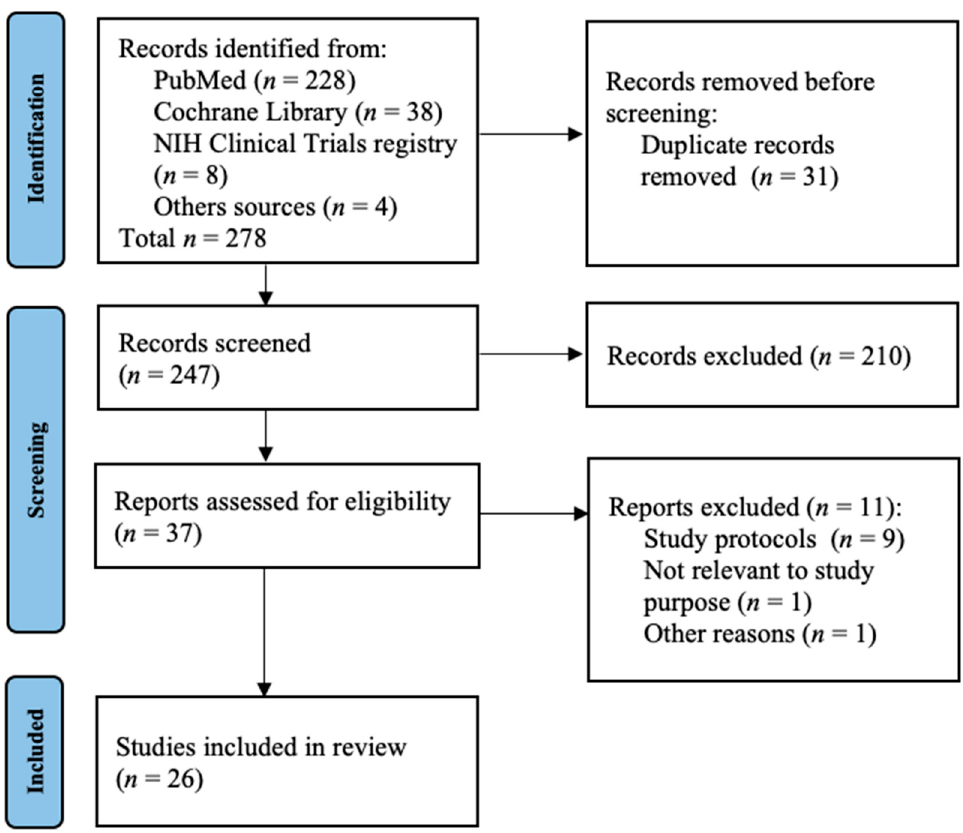
Figure 3. Study selection diagram.